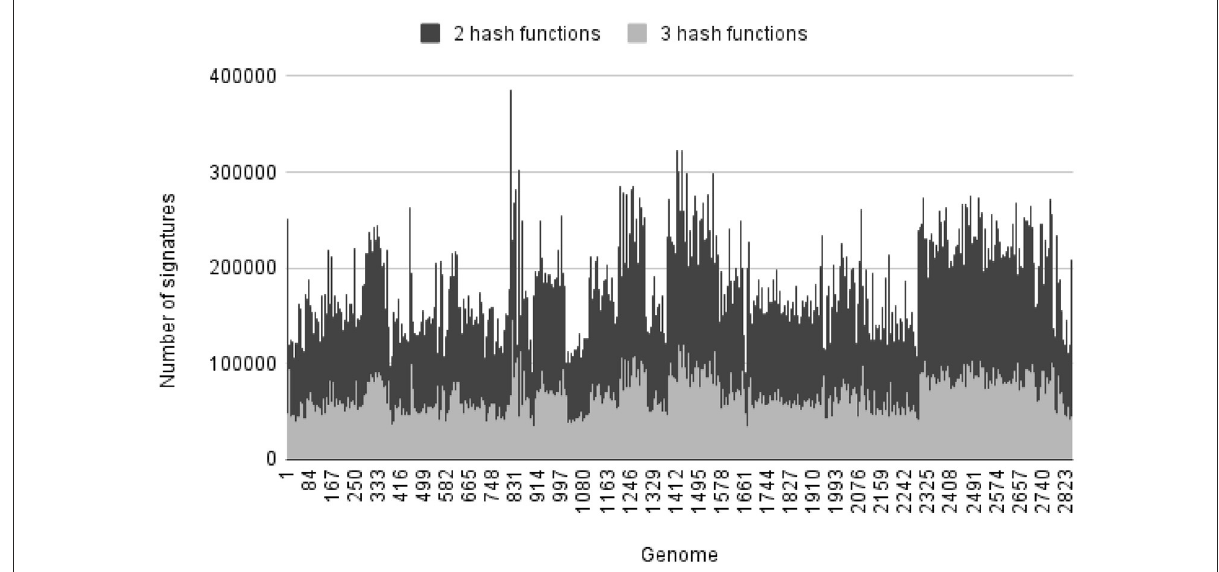
FIGURE2 Number of unique signatures for each genome in genome set S2 in the change of number of hash functions.